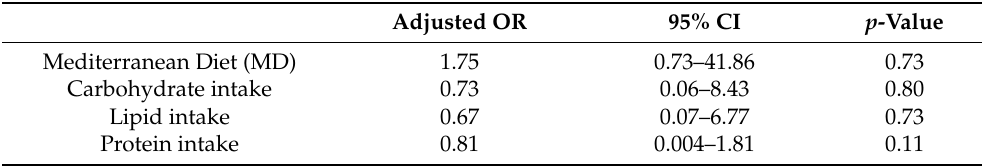
Table 4. Odds ratios (ORs) and 95% confidence intervals (CIs) for the severity of IBS-symptoms with dietary habits.